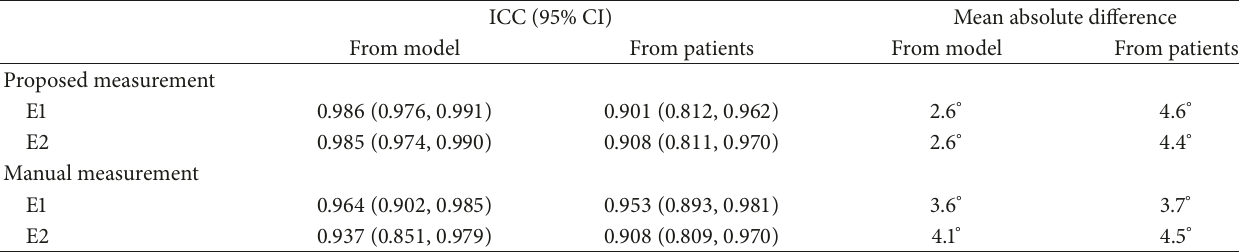
Table 1: Intraobserver analyses.